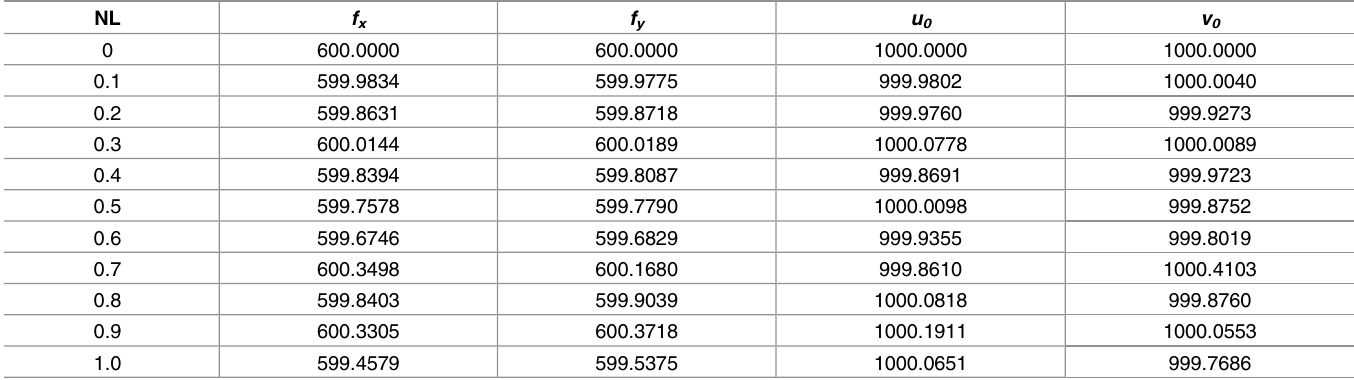
Table 1. Average of intrinsic parameters under different noise levels.